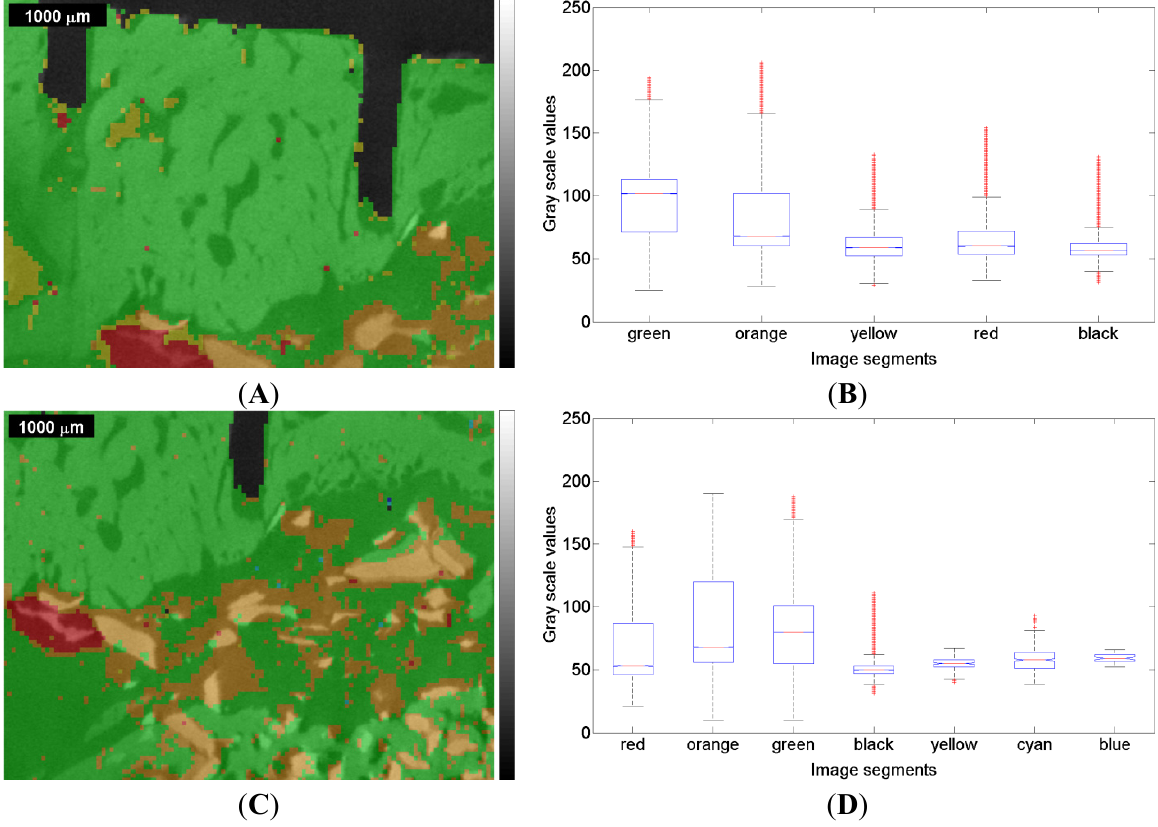
Figure 7. Raman based image segmentation (see Figure 6) overlapped with the µ-CT image represented by gray scale values, and box plot for the one-way ANOVA test result for the first measurement (ROI 1) of the sinus grafted bone sample ( A , B ); and for the second measurement (ROI 2) of the same sample ( C , D ). See also Tables 3 and 4 for the association of a color to a given material: red—Bio-Oss ® , orange—phosphate, green—pork bone, yellow—pork